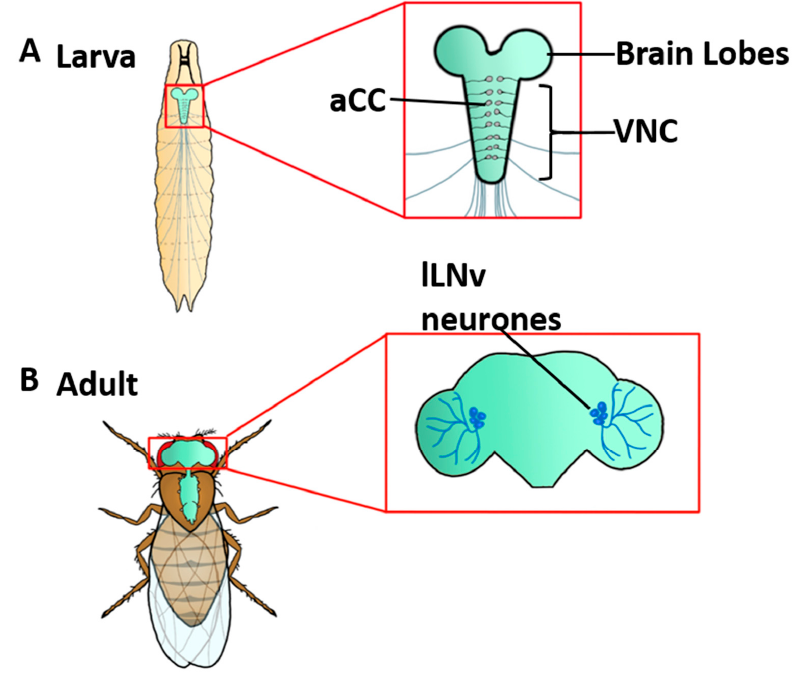
Figure 1. Diagrammatic representation of larval and adult Drosophila. ( A ) Representation of a Drosophila larva, with central nervous system (CNS) shown in blue. The expanded region shows the CNS with the approximate location of the segmentally repeated anterior corner cell (aCC) motoneuron along the dorsal midline of the ventral nerve cord (VNC). ( B ) Representation of adult Drosophila with CNS shown in blue. Expanded region shows the central brain region with approximate location of lLNv clock neurons.